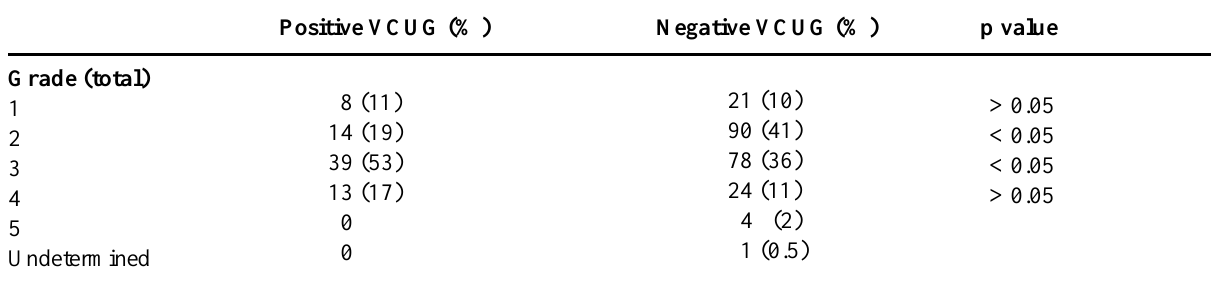
Table 1 – Correlation between the voiding cystoureterography (VCUG) findings and reflux